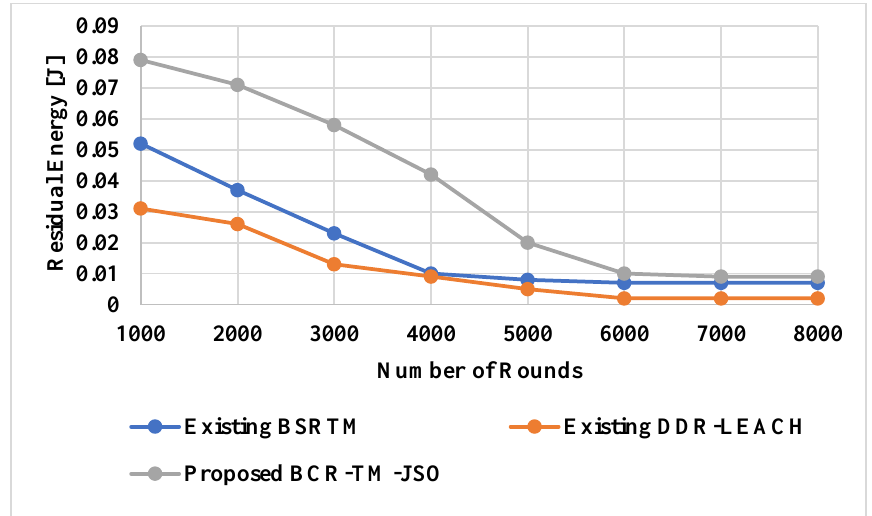
Figure 12. Performance of residual energy with existing methods [21, 25].